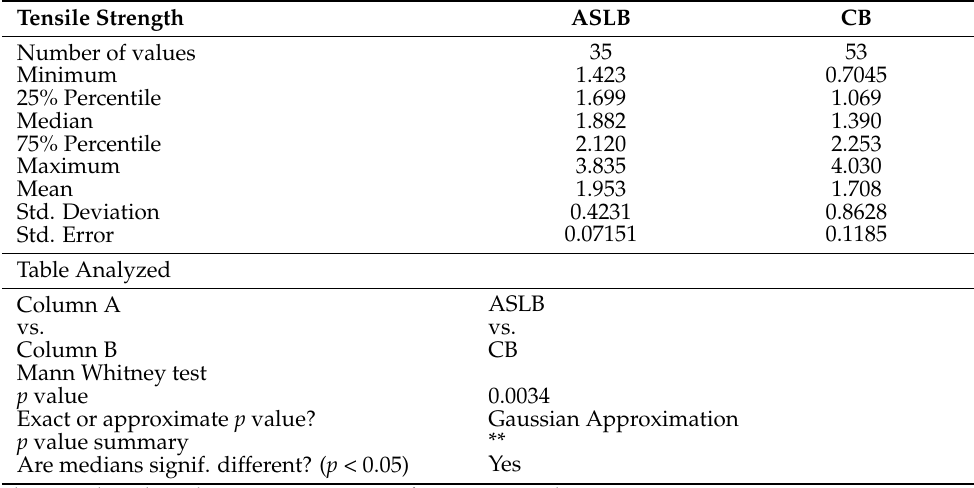
Table A5. Tensile strength: active self-ligating vs. conventional brackets. Tensile Strength ASLB Number of values